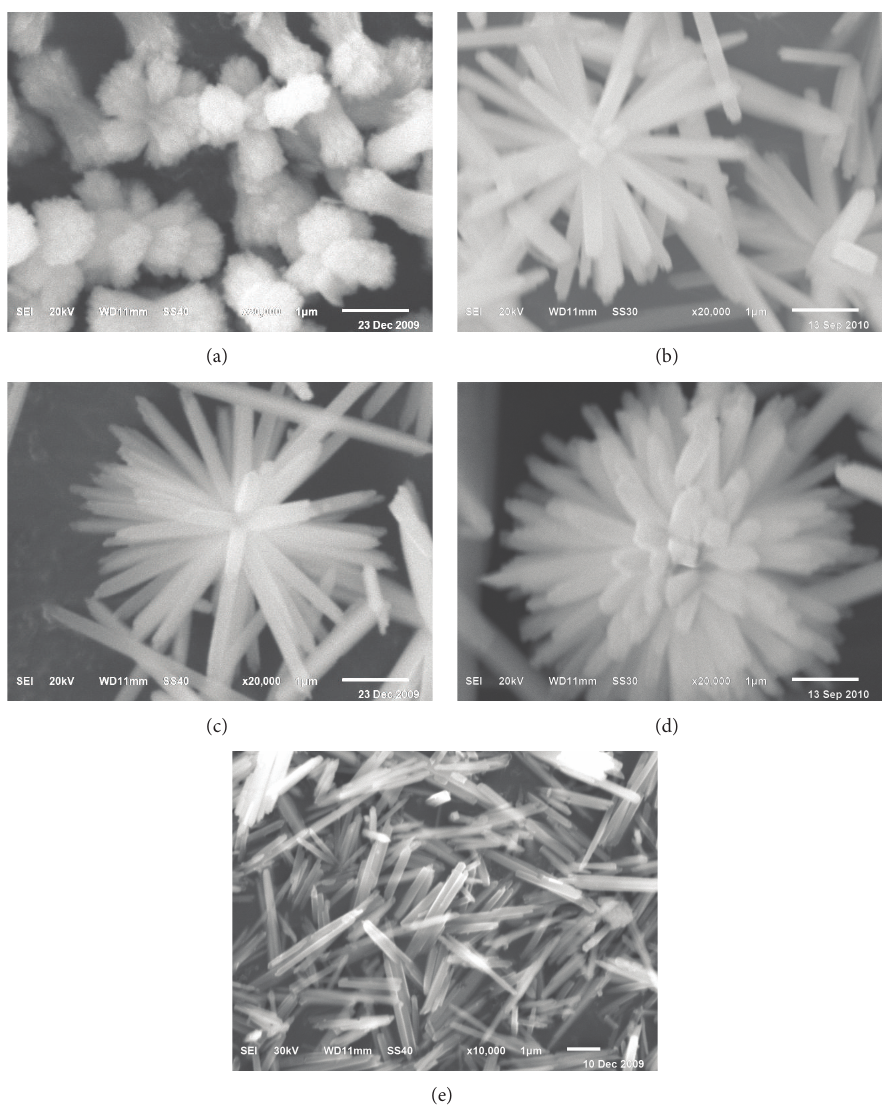
Figure 3: SEM images of SmVO 4 nanocrystals synthesized under 180 ∘ C, with different reaction conditions: (a) EDTA, pH = 4; (b) EDTA, pH = 6; (c) EDTA, pH = 8; (d) EDTA, pH = 10; (e) absence of EDTA, pH =